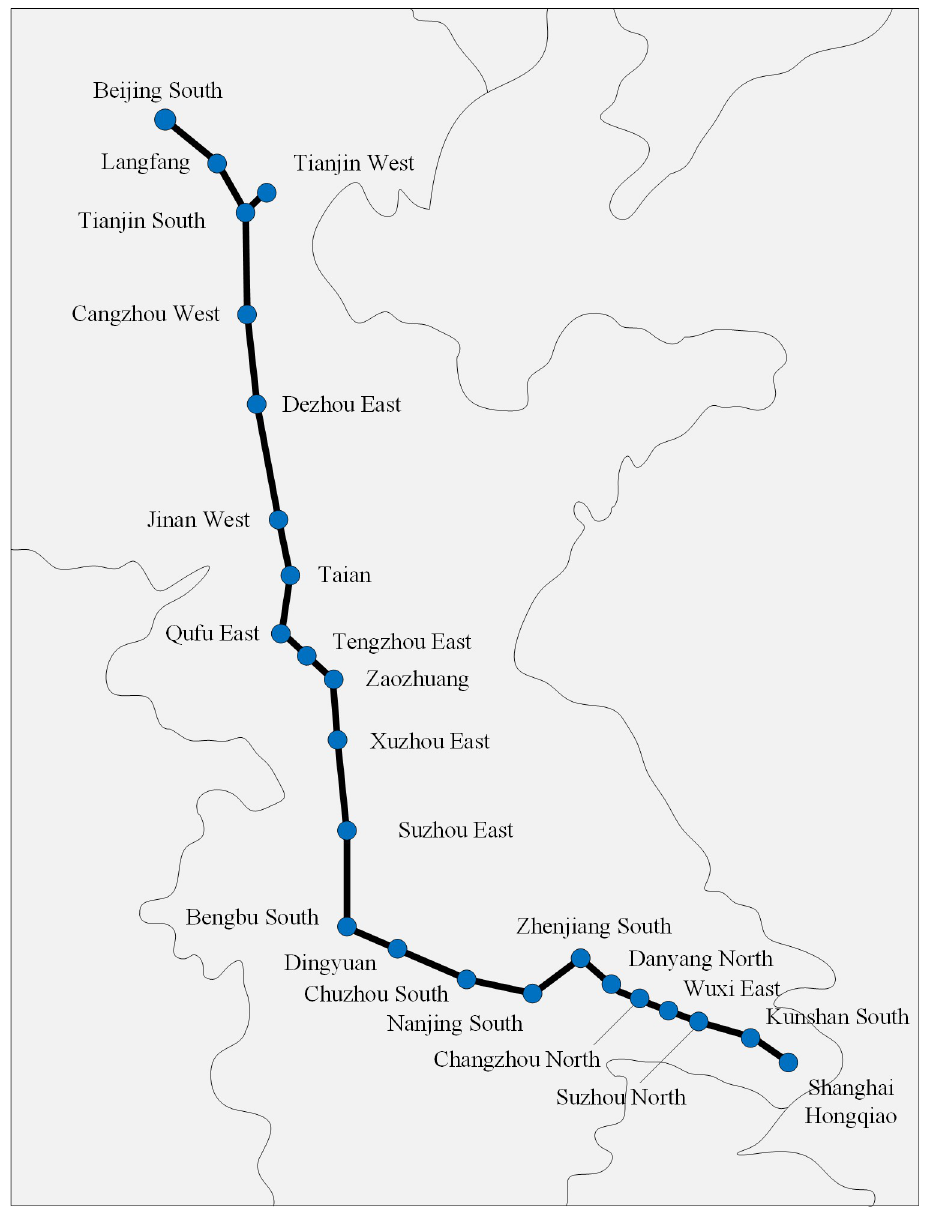
Fig 6. Beijing-shanghai high-speed railway